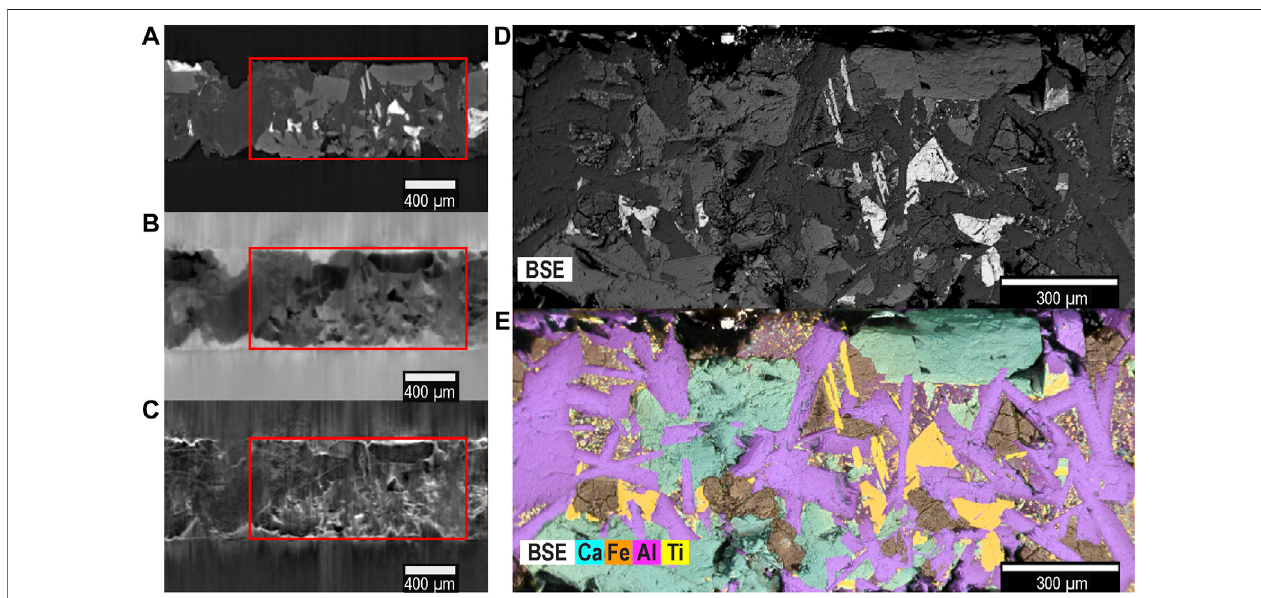
FIGURE4| ThethreeGB-SRCTsignalscomparedtoSEM-BSEmicrographandassociatedSEM-EDSmap.TheredboxescorrespondtothelocationoftheSEM- BSE micrograph and the SEM-EDS chemical map. (A) Transmission signal; (B) DPC signal; (C) Dark- fi eld signal; (D) SEM-BSE micrograph; (E) false color SEM-EDS map showing the spatial distribution of Ca (cyan), Fe (orange), Al (pink), and Ti (yellow) overlain on the SEM-BSE (white) micrograph.